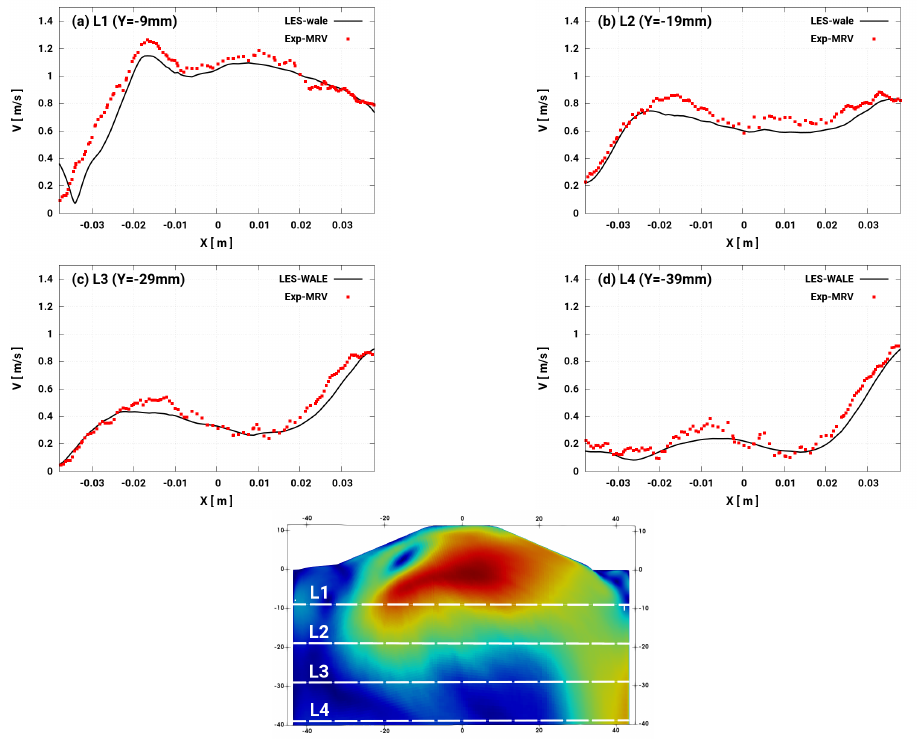
Figure 10. Comparison of velocity profile for LES and MRV across plane at Z = 0 mm along various lines as represented in the bottom figure.